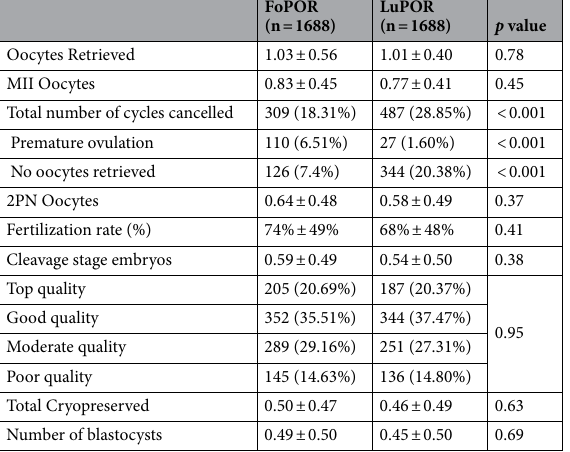
Table 3. Comparison of mean ± sd of IVF laboratory outcomes as well as day 3 embryo grading following FoPOR and